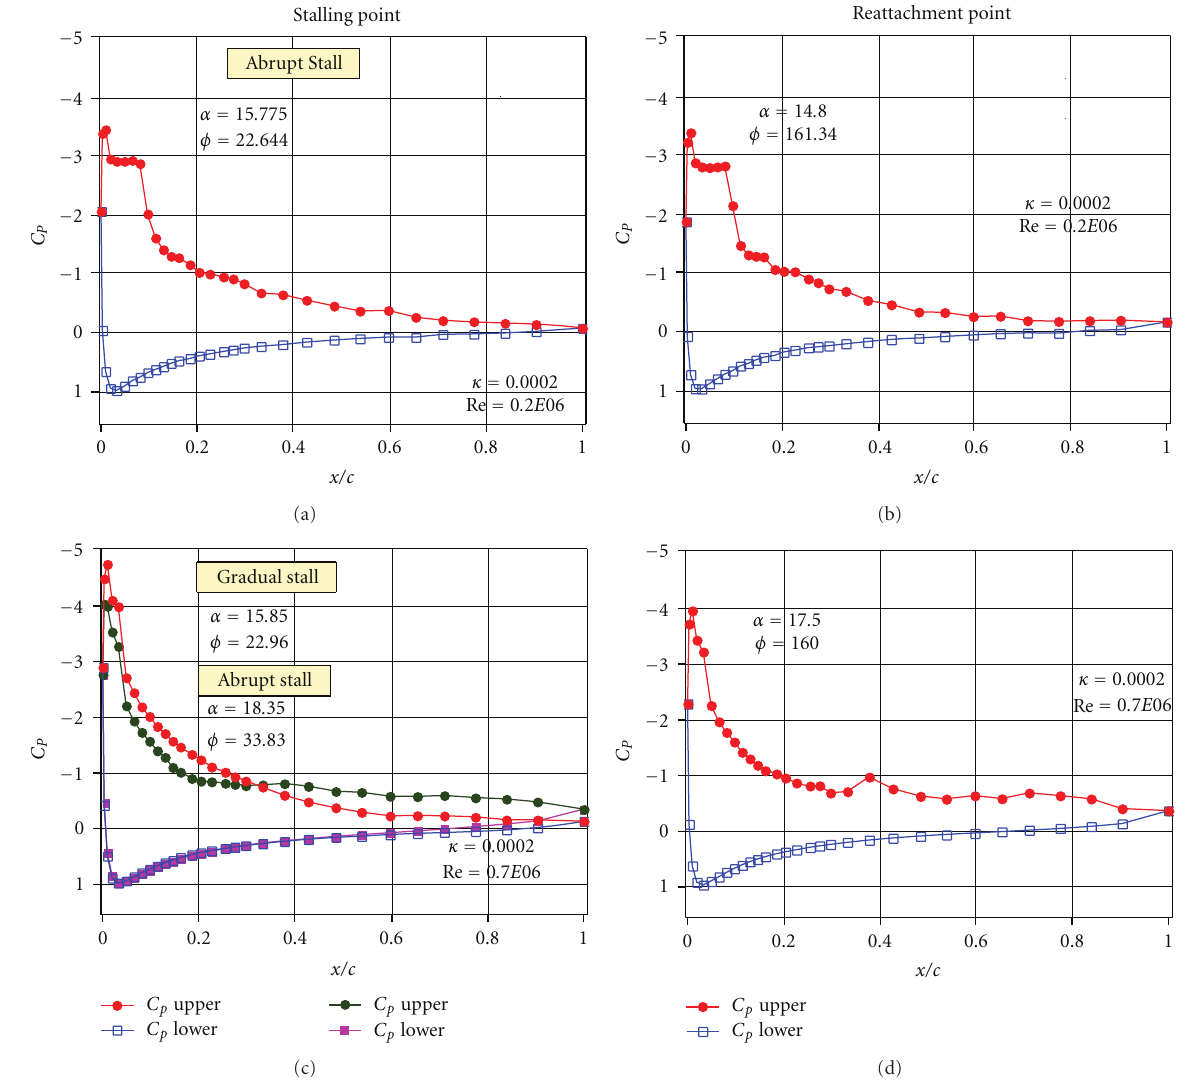
Figure 15: C p Distribution plot at stalling and reattachment points for Re = 0 . 2 E 06 and 0 . 7 E 06 at constant κ = 0 . 0002.